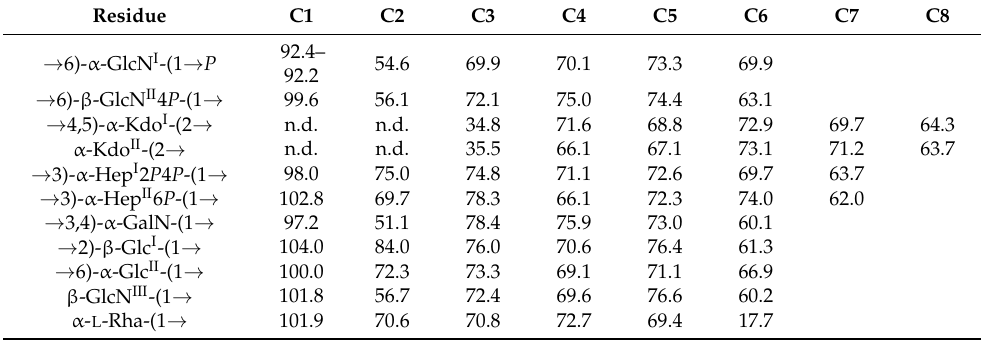
Table 4. 13 C NMR chemical shift data of 1 recorded in D 2 O at 310